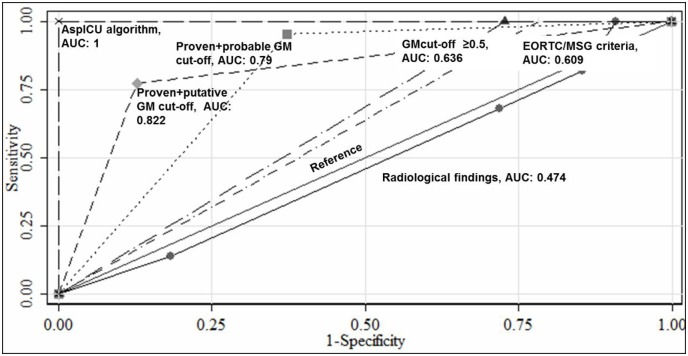
Diagnostic accuracy for the detection of invasive aspergillosis with different tests and diagnostic criteria (using clinically relevant microscopy and culture positive cases as the reference).